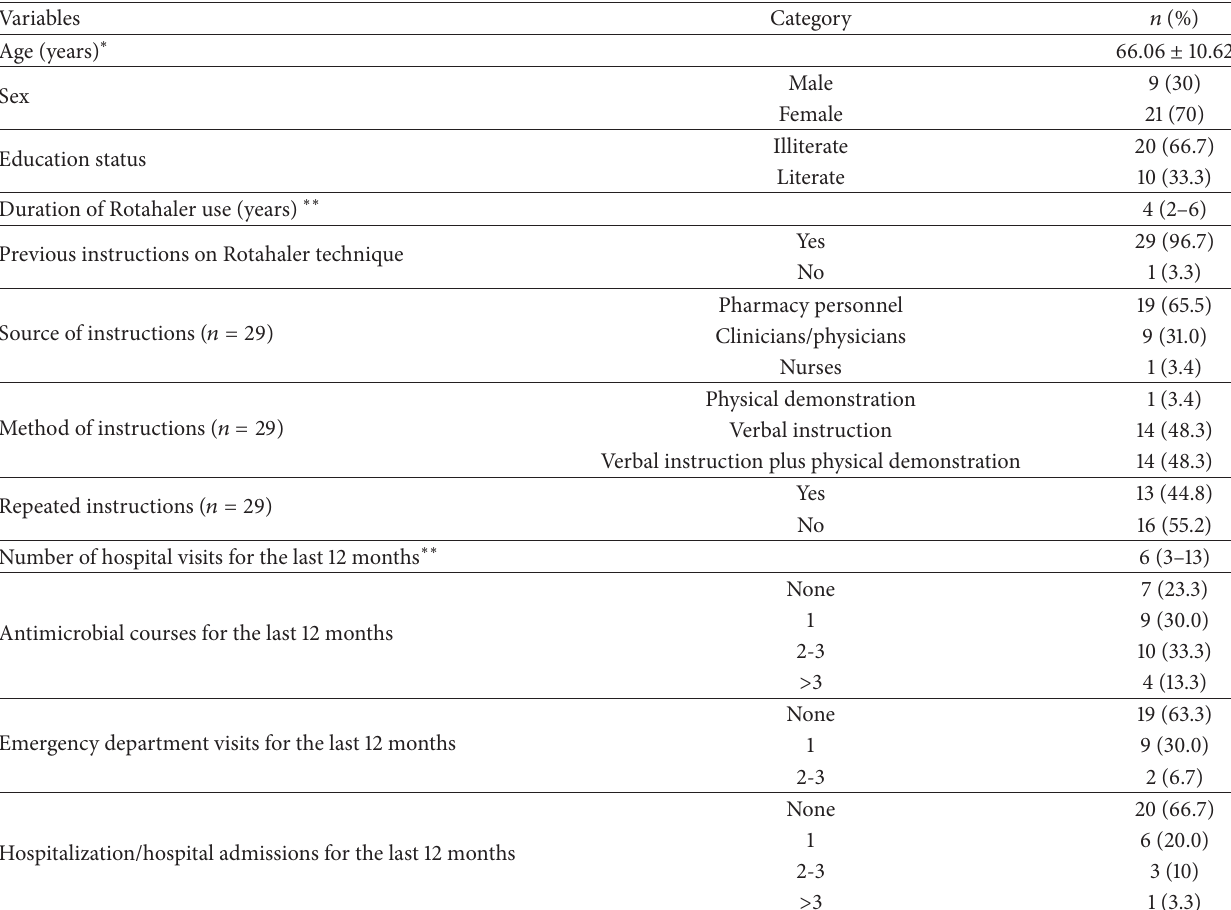
Table 1: Baseline characteristics of the patients assessed for the intervention ( 𝑛 = 30 ).